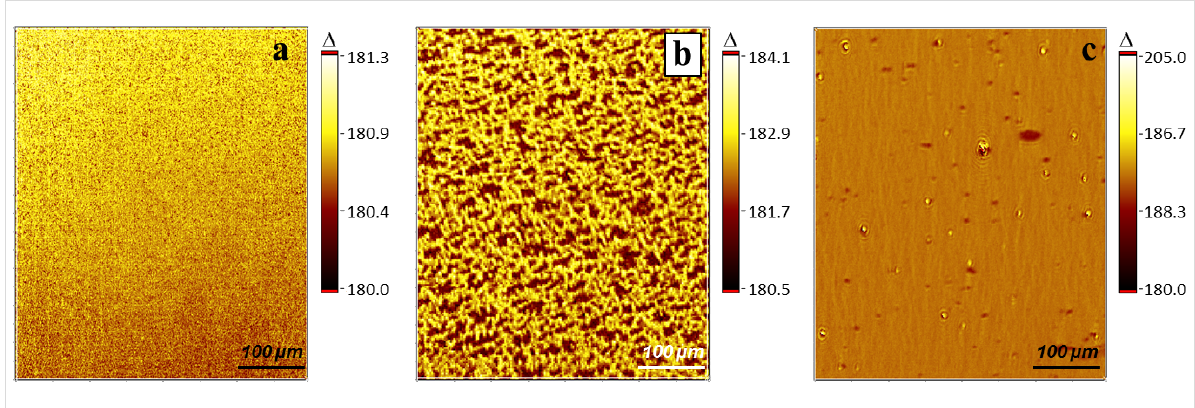
Figure 6: Surface-pressure-dependent structuration of PLGA-based Langmuir layers observed by ellipsometric Δ mapping at room temperature at (a)10 mN·m − 1 , (b) 12 mN·m − 1 and (c) 25 mN·m − 1 , respectively.